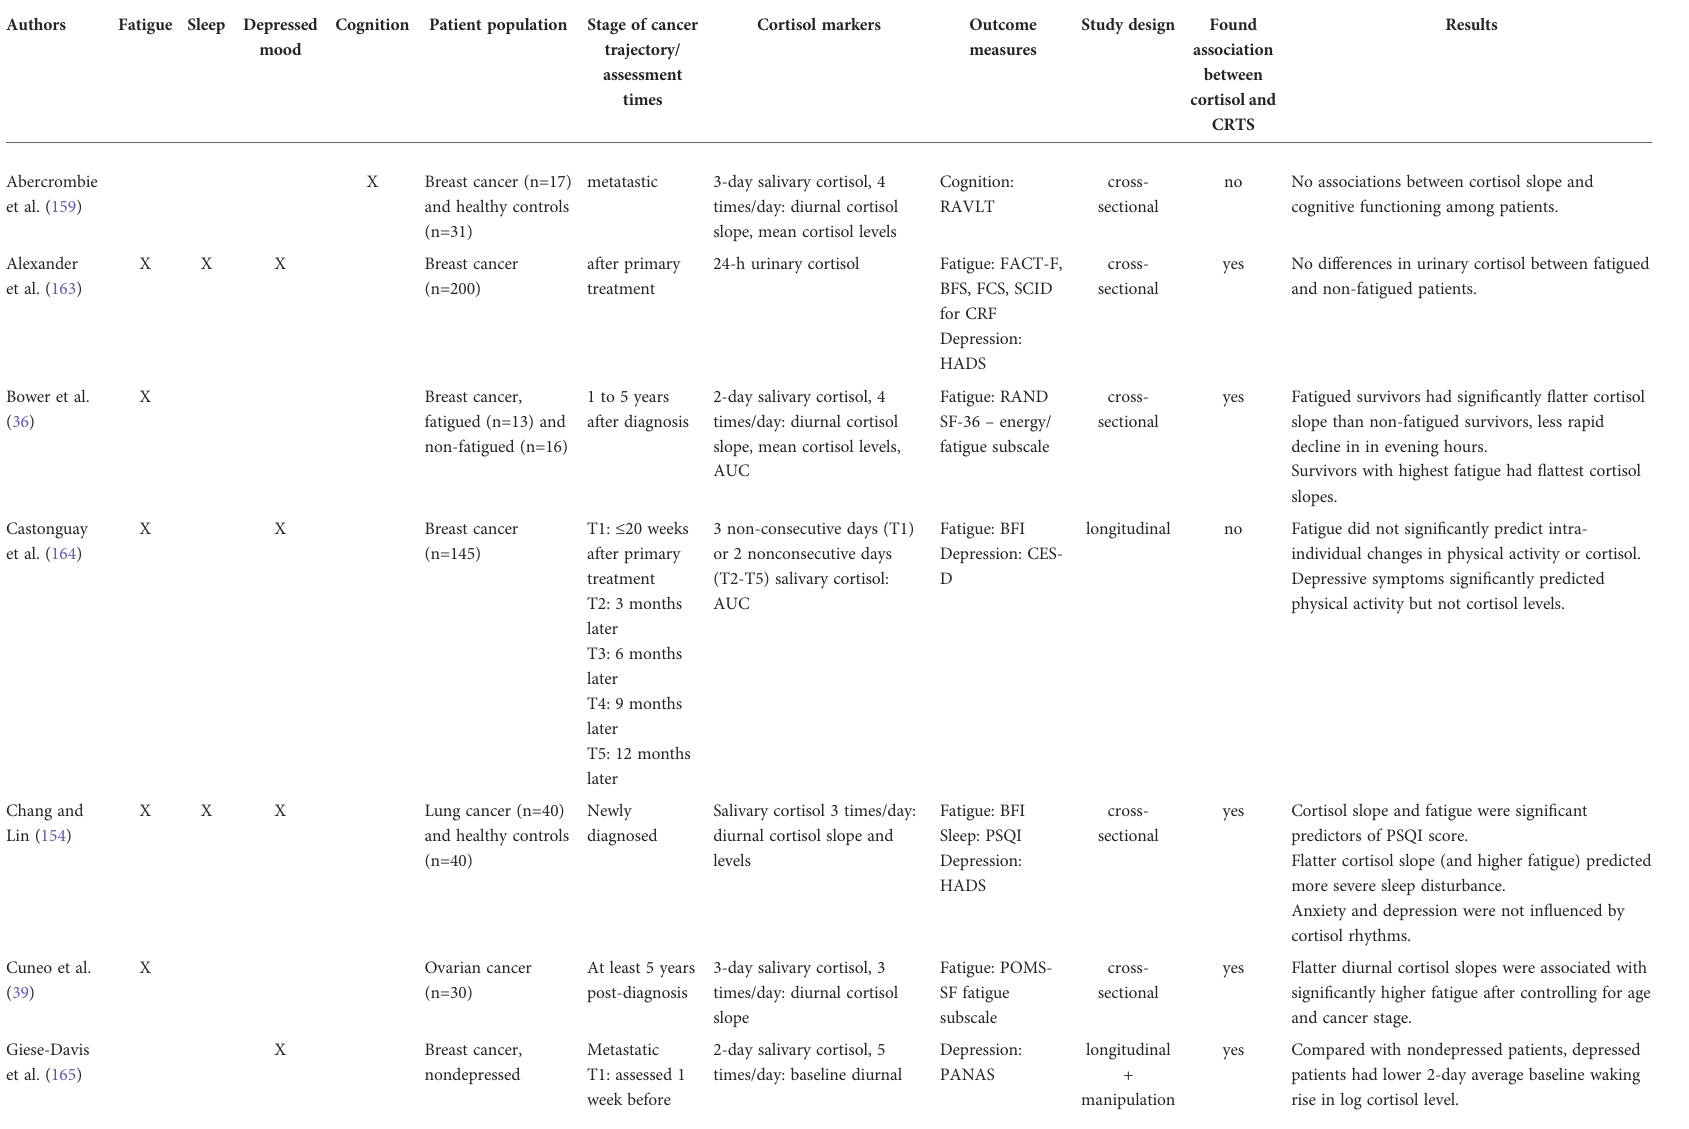
TABLE 2 Summary of studies that examined cortisol and cancer- and treatment-related symptoms